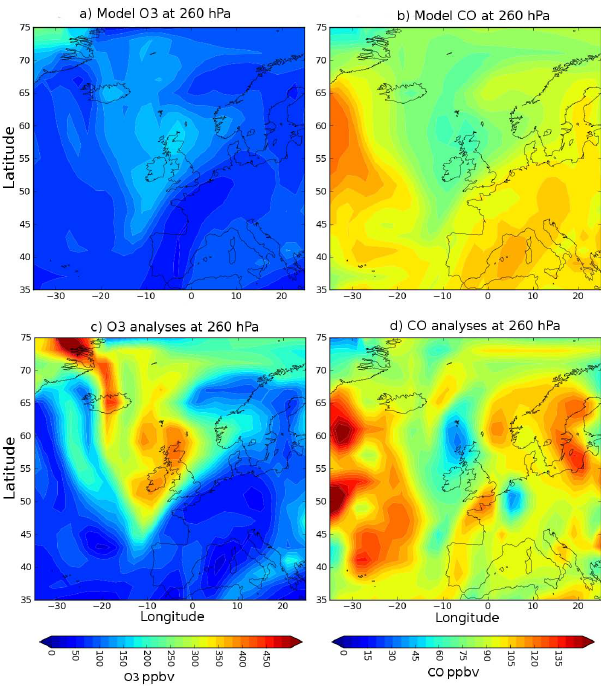
Fig. 1. Longitude–latitude maps at 260hPa of model O 3 (a) , model CO (b) , O 3 analyses (c) and CO analyses (d) for 15 August 2007 at